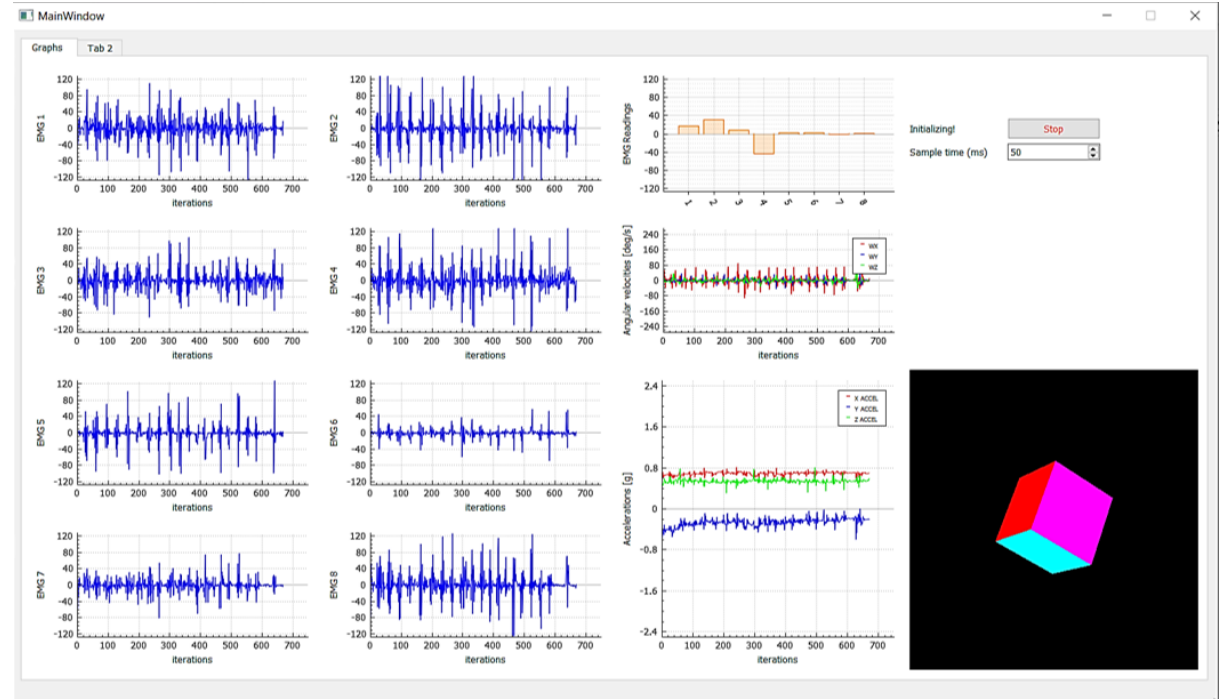
Figure 3. The Myo visualization tool interface that streams the electromyography (EMG) signal detected by the armband. The first two columns represent the EMG sensors detected by pods 1-8. In the third column, the first graph on the top is the EMG representation as a whole, while the other two are angular velocities and